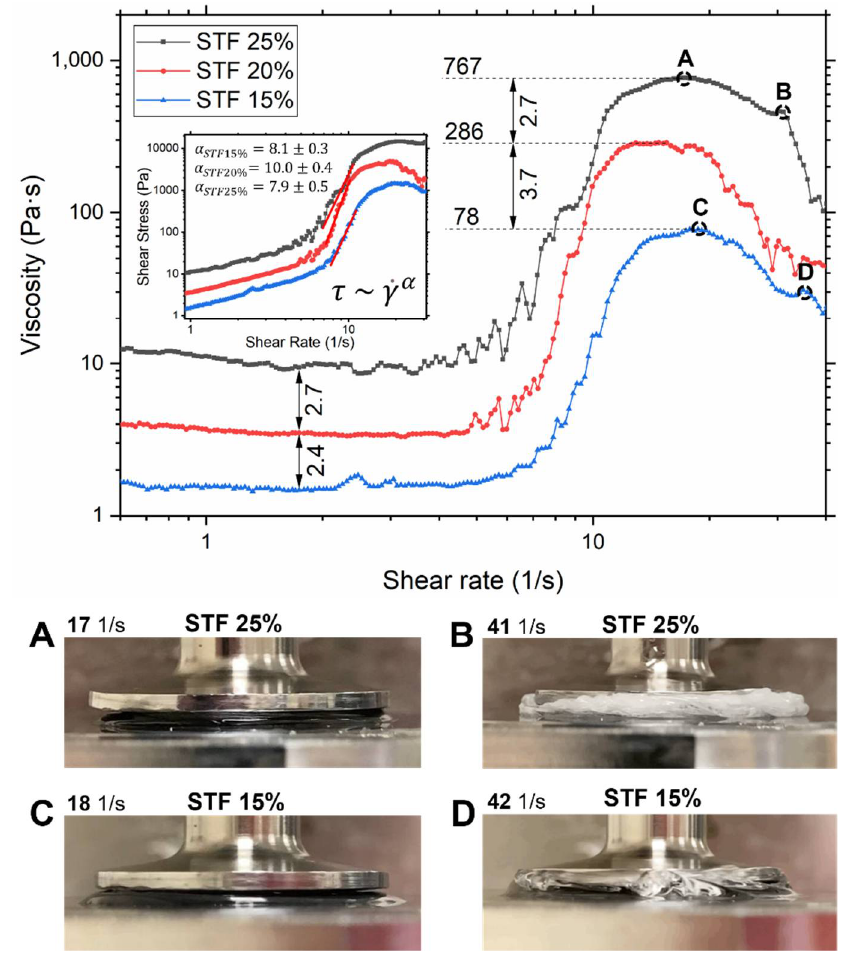
Figure 3. Flow rheological analysis of STF at three weight fractions. Viscosity as a function of shear rate in a parallel plates geometry with a 0.5 mm gap. Numbers on the arrows represent ratios of viscosities at different stages, the first two values at the bottom during the Newtonian stage, values on top ratios at the maximum viscosities. An additional graph inside the main is a shear stress-rate plot, which was used for power-law fitting to establish the regime of shear thickening (DST or CST). ( A , C ) Photos of STF 25% and 15% during flow tests at the maximum viscosity when fluid starts to slip off (17 1/s and 18 1/s, respectively), ( B ) when STF 25% becomes cloudy (41 1/s); ( D ) in contrast to STF 25%, STF 15% did not demonstrate any change in optical properties (at 42 1/s).